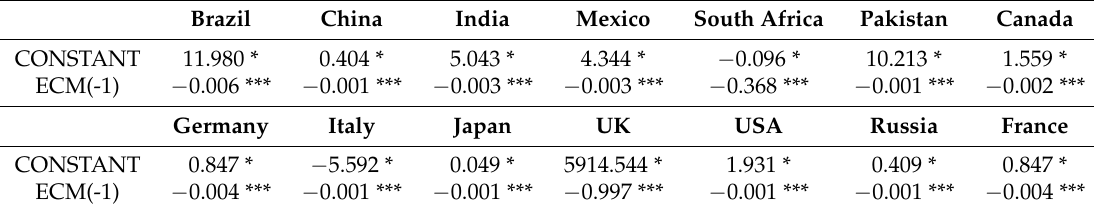
Table 2. Vector error correction